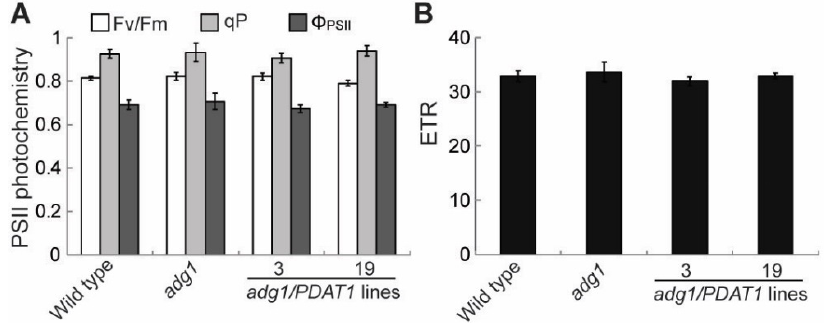
Figure 5. Chlorophyll fluorescence parameters in leaves of six-week-old plants grown on soil. ( A ) Photosystem II (PSII) photochemistry. ( B ) Photosynthetic electron transport rate (ETR).